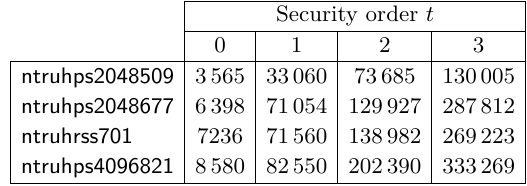
Table 6: Cycle counts for key generation (exponentiation method) for all parameters of NTRU , in thousands of cycles, on Intel(R) Core(TM) i7-1065G7 CPU @ 1.30GHz .